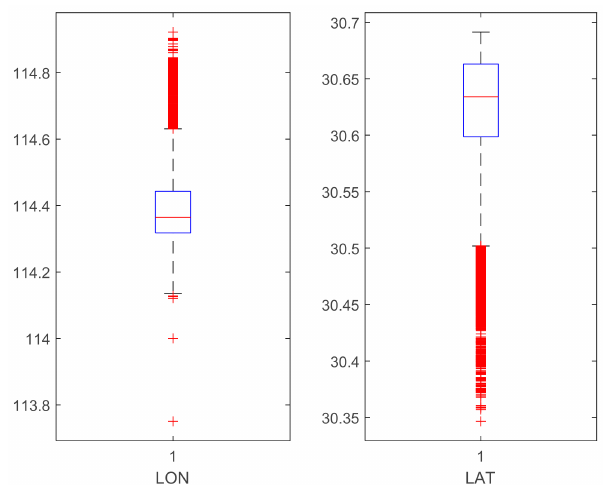
Figure 3. LON and LAT distributions.